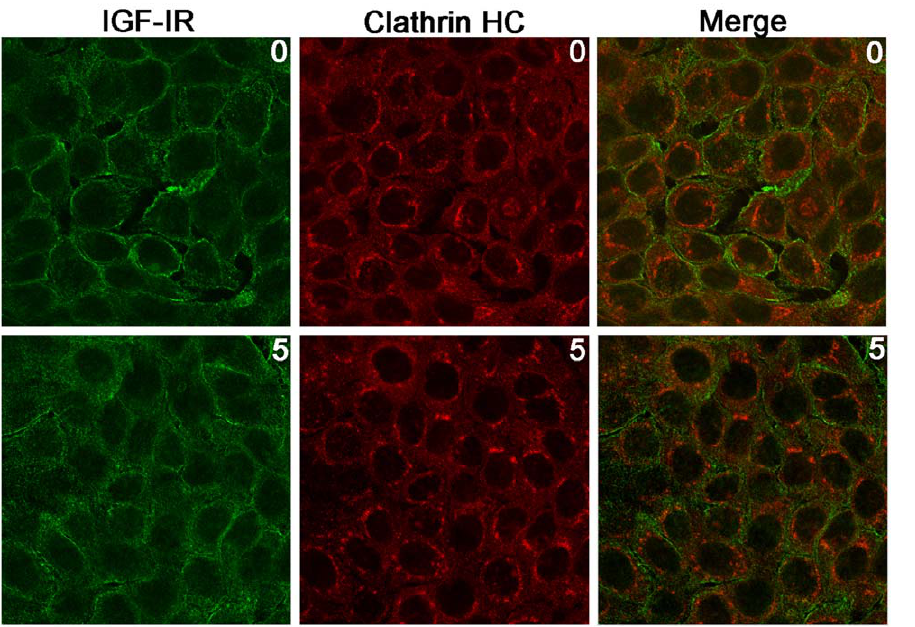
Figure 4. IGF1 does not Induces IGF-IR and Clathrin Heavy Chain co-localization. HaCat cells were treated with IGF1(10 nM) for 5 min, fixed in 4% formaldehyde, permeabilized with Methanol at 2 20 u C, labeled with a rabbit anti-Clathrin Heavy Chain (red) and a mouse anti-IGF-IR (green), antibody and imaged by confocal immunofluorescence microscopy.